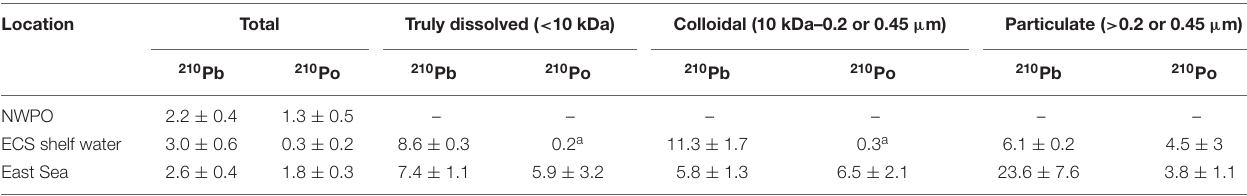
TABLE 1 | Scavenging rate constants (per year) of total, truly dissolved ( < 10 kDa), colloidal (10 kDa–0.2 µ m), and particulate ( > 0.2 µ m) 210 Pb and 210 Po in the upper 0–50 m of the northwestern Pacific Ocean (NWPO), the East China Sea (ECS) shelf water, and the East Sea. Location Total